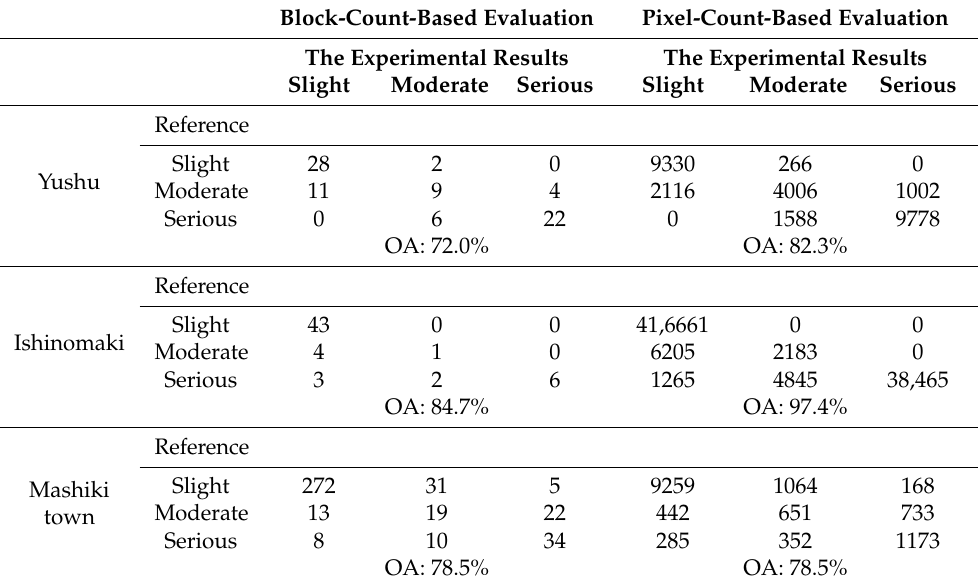
Table 10. The comparison of two evaluation methods in three study sites. Block-Count-Based